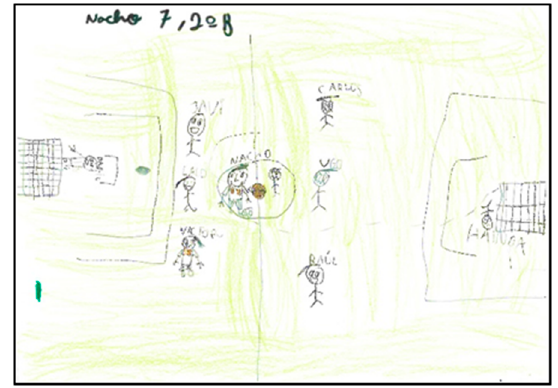
Figure 14. Representation of movement. Nacho. 2°B.